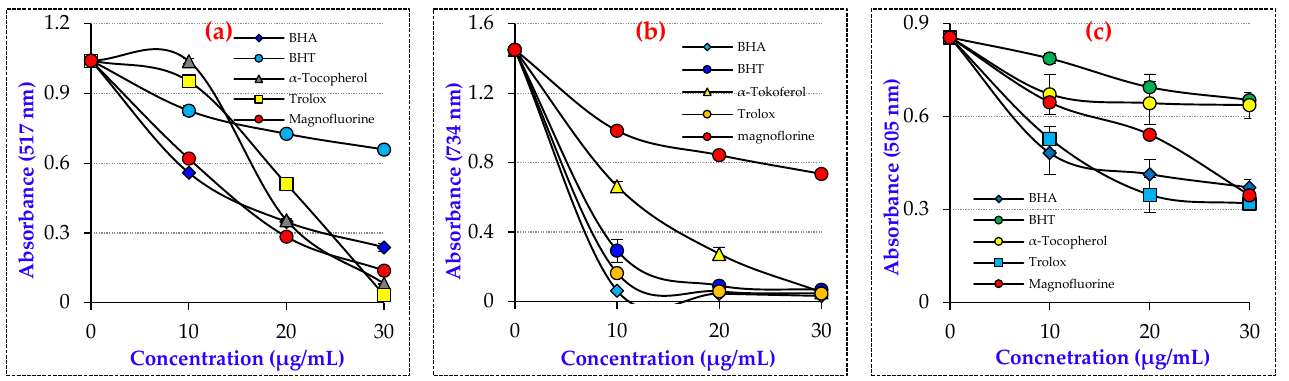
Figure 2. Radical scavenging effects of Magnofluorine and positive controls. a . DPPH • scavenging